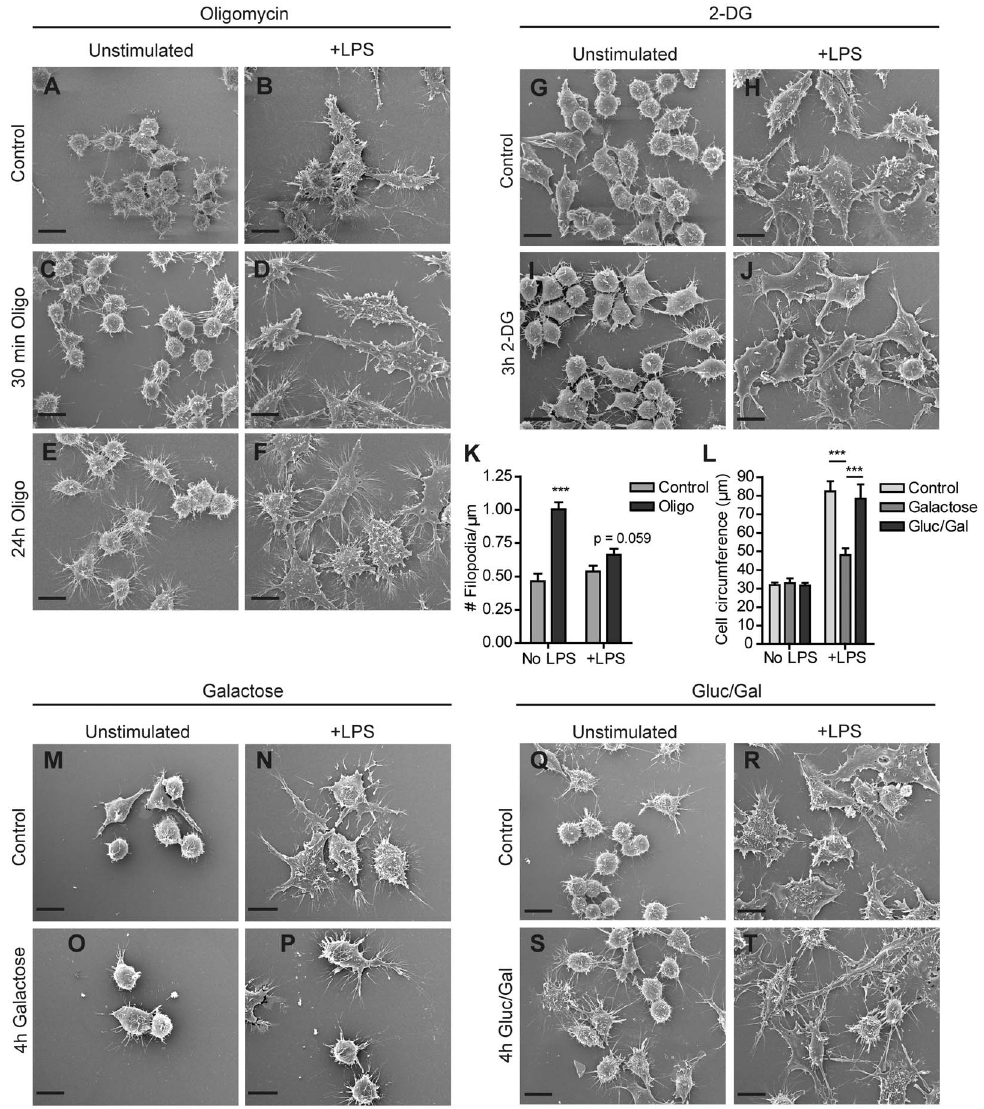
Figure 4. Effect of glucose deprivation and glycolysis or OXPHOS inhibition on morphology of RAW 264.7 cells. Cells were seeded on glass coverslips, incubated in control medium or medium containing 2.5 m M oligomycin and 25 mM glucose (A–F), 10 mM 2-DG and 25 mM glucose (G–J), 10 mM galactose and no glucose (M–P), or 1 mM glucose and 10 mM galactosel (Q–T) for the indicated time periods and stimulated overnight with LPS or left unstimulated. Coverslips were fixed and subjected to scanning electron microscopy. The number of filopodia extending radially from the cell surface was determined for control cells and cells treated for 24 hours with oligomycin, in the presence and absence of LPS (K). The average cell circumference was determined for cells in control medium or medium containing 10 mM galactose, or 1 mM glucose and 10 mM galactose (L). (***p , 0.001, unpaired t-test). (Bar=10 m m).